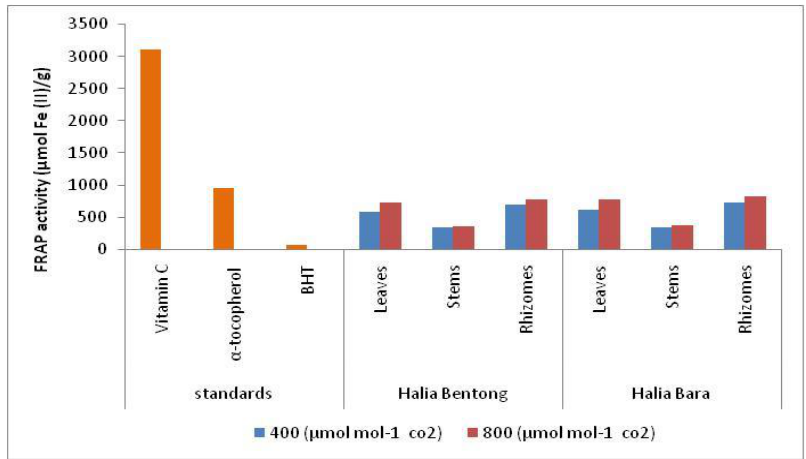
Figure 2. Effect of elevated CO on FRAP activity of the methanol extracts in different 2 part of two varieties of Z. officinale, compared with positive controls: vitamin C, α-tocopherol and butylated hydroxytoluene